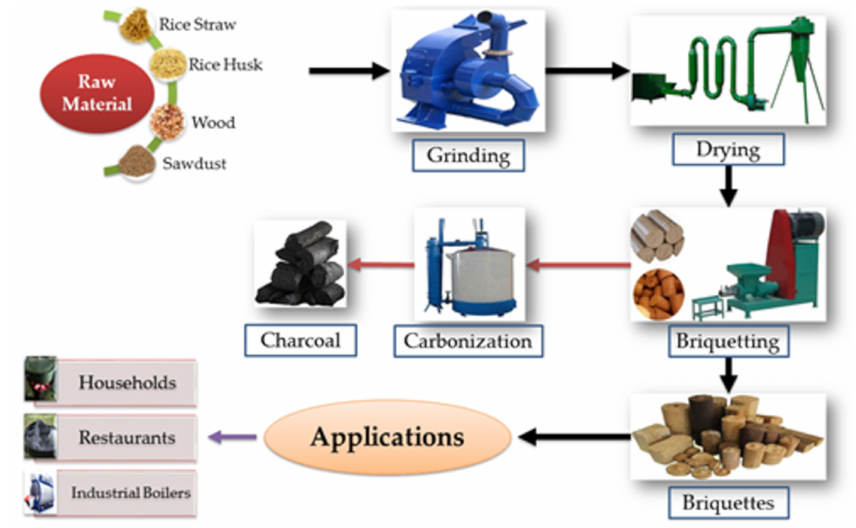
Figure 3. Schematic diagram of briquette fuel